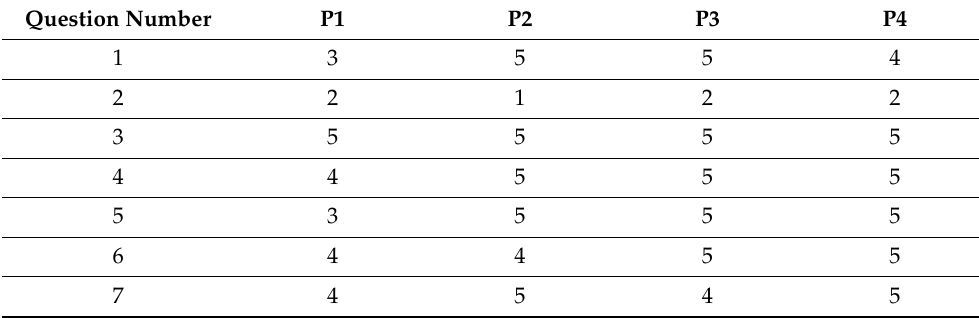
Table 2. Table listing rating scale answers to questions listed in Table